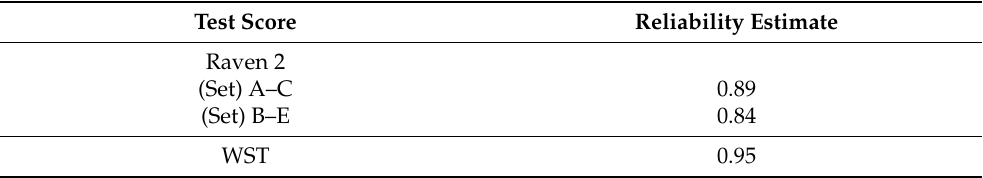
Table 2. Reliability estimates of all test scores. When achievable, estimates are preferentially in terms of consistency reliability ( r SB ) or Cronbach’s α ; when consistency reliability was not achievable, estimates are in terms of test–retest reliability ( r tt